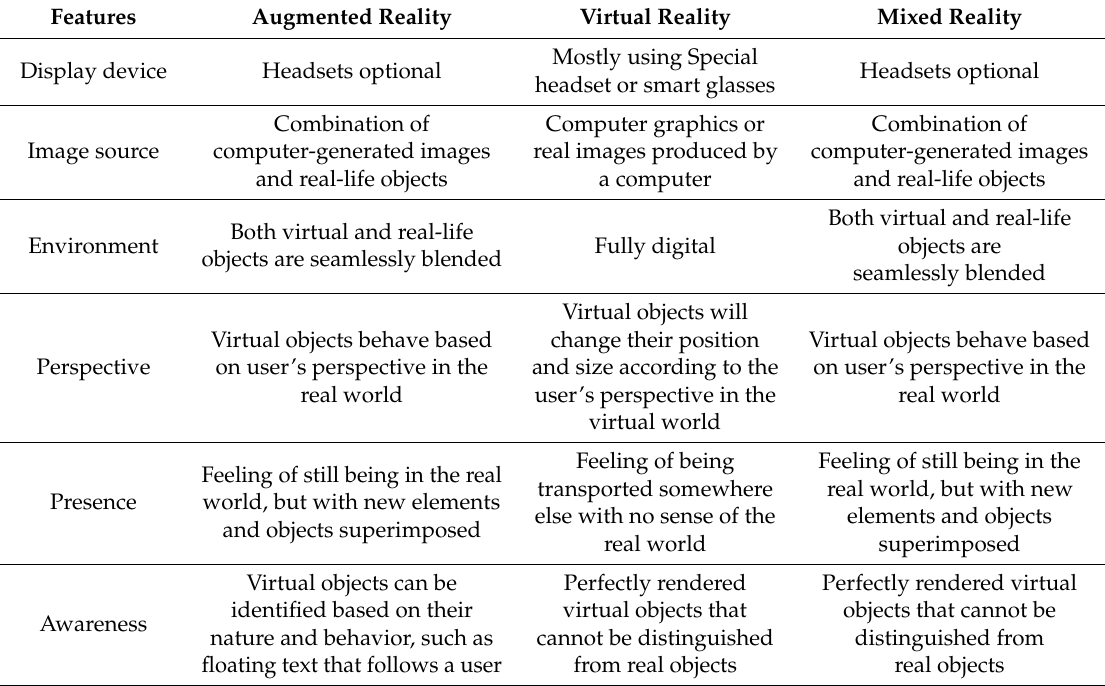
Table 1. Comparison according to three key space specifications (Adopted from